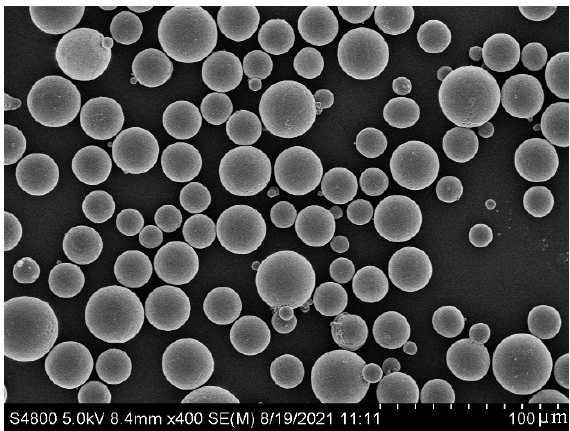
Figure 1. Microscopic morphology of Ti6Al4V ELI alloy powder.